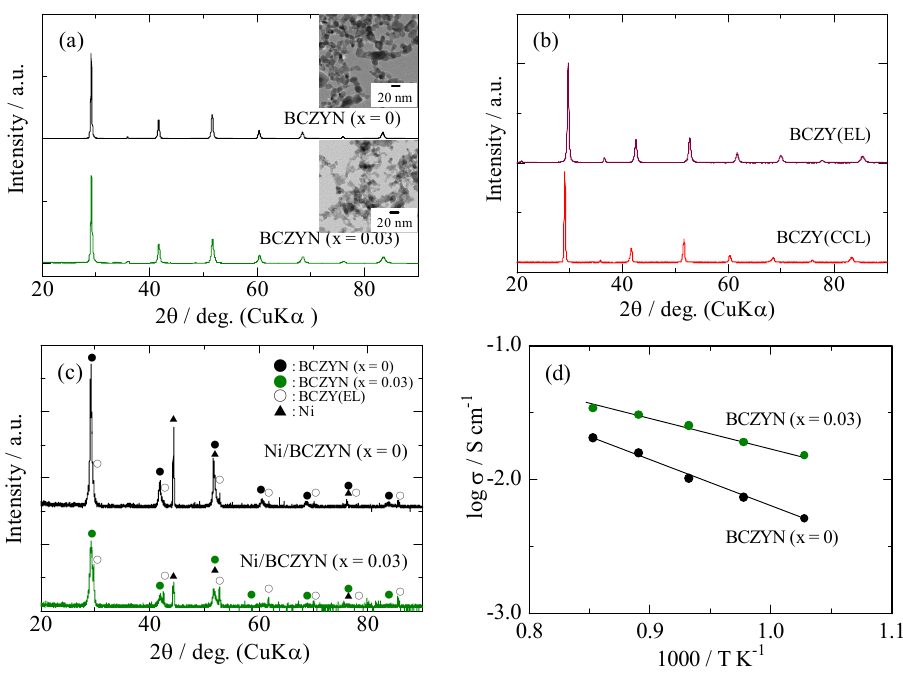
Figure 2. X ‐ ray powder diffraction (XRD) patterns and transmission electron microscopy (TEM) images of BaCe 0.5 Zr 0.3 − x Y 0.2 Ni x O 3 −δ (BCZYN, x = 0 and 0.03) with fused ‐ aggregate network structure ( a ), BaCe 0.5 Zr 0.3 Y 0.2 O 3 −δ (BCZY(CCL)) and BaCe 0.1 Zr 0.7 Y 0.2 O 3 −δ (BCZY(EL)) sintered at 1650 °C, 10 h ( b ), Ni/BCZYN (x = 0 and 0.03) catalyst layers (CLs) sintered at 1000 °C in 4% hydrogen atmosphere ( c ), and the arrhenius plots of electrical conductivity of BCZYN (x = 0 and 0.03) in 4% hydrogen atmosphere (Ar balance) ( d ).